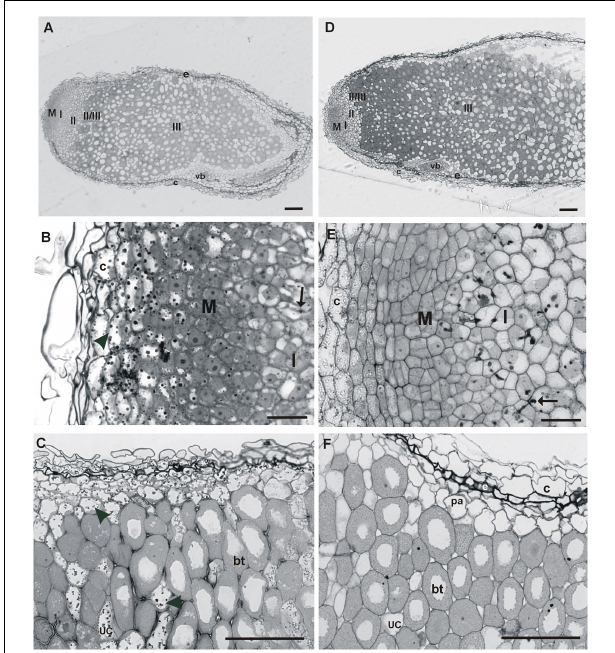
FIGURE 3 | Longitudinal sections of fully developed T. repens root nodules from the metal-polluted waste heap (A–C) and non-polluted reference (D–F) area. M—meristem, I—infection thread penetration zone, II—early symbiosis zone, II/III—inter-zone with large amyloplasts, III—nitrogen fixation zone; arrow—infection thread, arrowhead—precipitates in vacuoles, bt—bacteroidal tissue, c—nodule cortex, e—nodule endodermis, pa—nodule parenchyma, uc—uninfected cell, vb—vascular bundle. Scale bars on images (A,B) correspond to 100 µ m, while scale bars on images (C–F) correspond